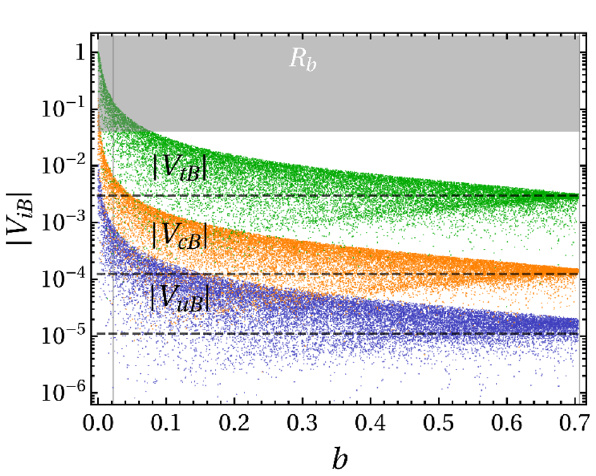
Figure 3 . The CKM matrix elements j V iB j as a function of b . The gray vertical lines mark the interval in (7.21). The shaded area shows the values excluded from R b [62]. The black dashed lines shows the case of the VLQ mixing only with third family with s (cid:18)